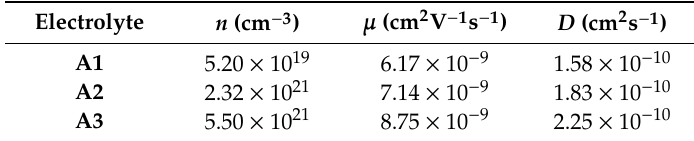
Table 5. The calculated transport parameters for the electrolyte